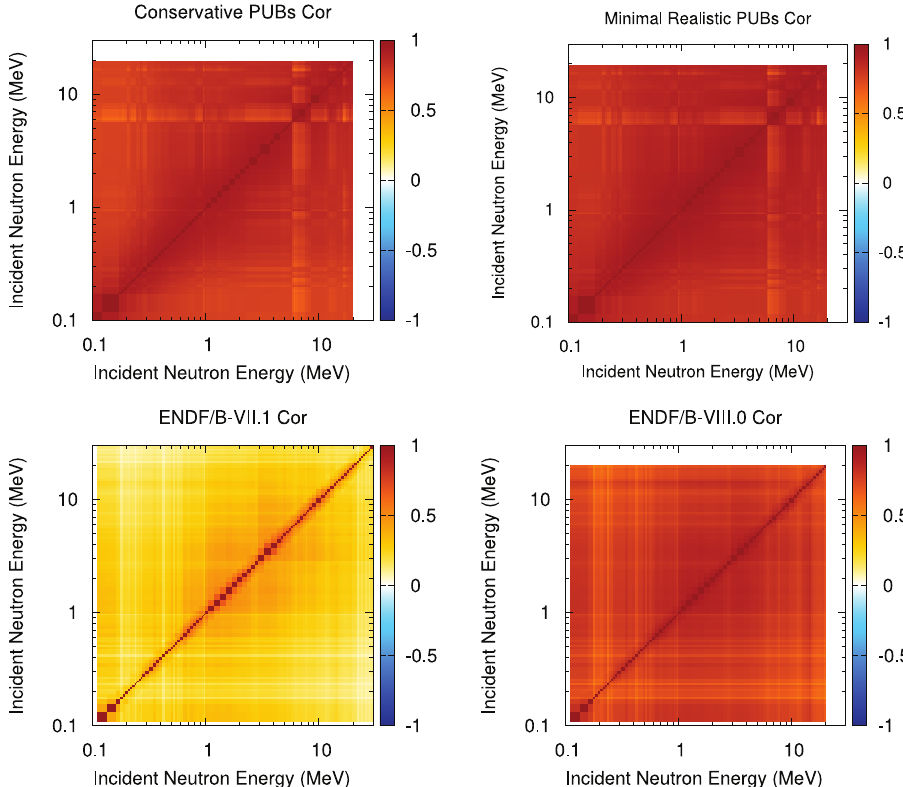
Fig. 6. Correlation matrices obtained for the conservative and minimal realistic PUBs bounds are compared to correlation matrices associated with ENDF/B-VII.1 and ENDF/B-VIII.0 239 Pu(n,f) cross